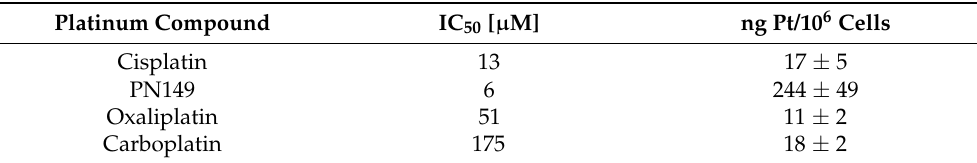
Figure 2. Cytotoxicity of PN149, cisplatin, oxaliplatin or carboplatin in the renal cell line ciPTEC. ciPTECs were incubated with ( A ) PN149, cisplatin or oxaliplatin or ( B ) carboplatin at the indicated concentrations for 24 h, and the cell count was determined after 48 h post-cultivation. Relative cell count (RCC) was obtained by normalization to the untreated control. Shown are the mean values of three independent experiments ± standard deviation. Table 1. Calculated IC 50 values and platinum accumulation following incubation of ciPTECs with 50 µM of either cisplatin, PN149 or oxaliplatin or 300 µM carboplatin for 2 h. Shown are mean values from at least three independent determinations ± standard deviation.